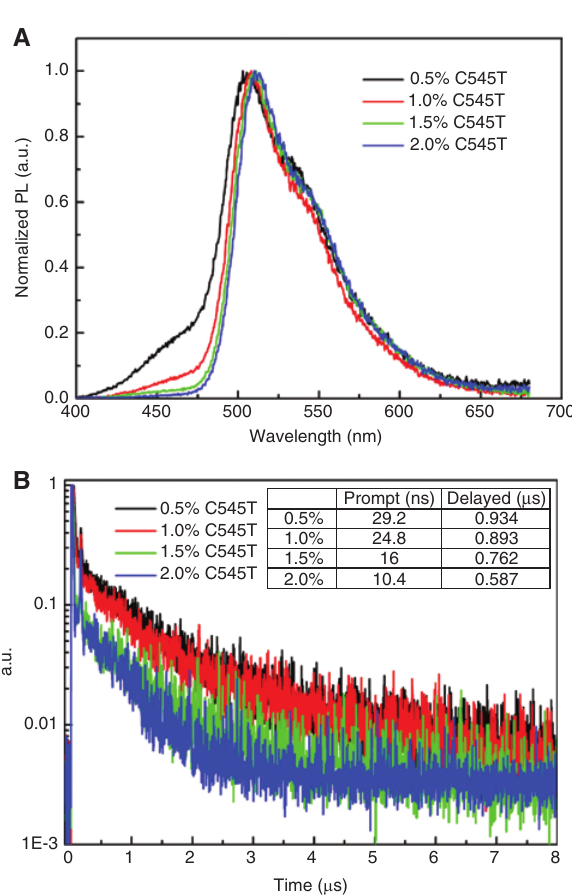
Figure 3: The PL spectra and transient PL decay curves with the film of DMAC-DPS: x% C545T under different concentrations. (A) The PL spectra. (B) The transient PL decay curves.